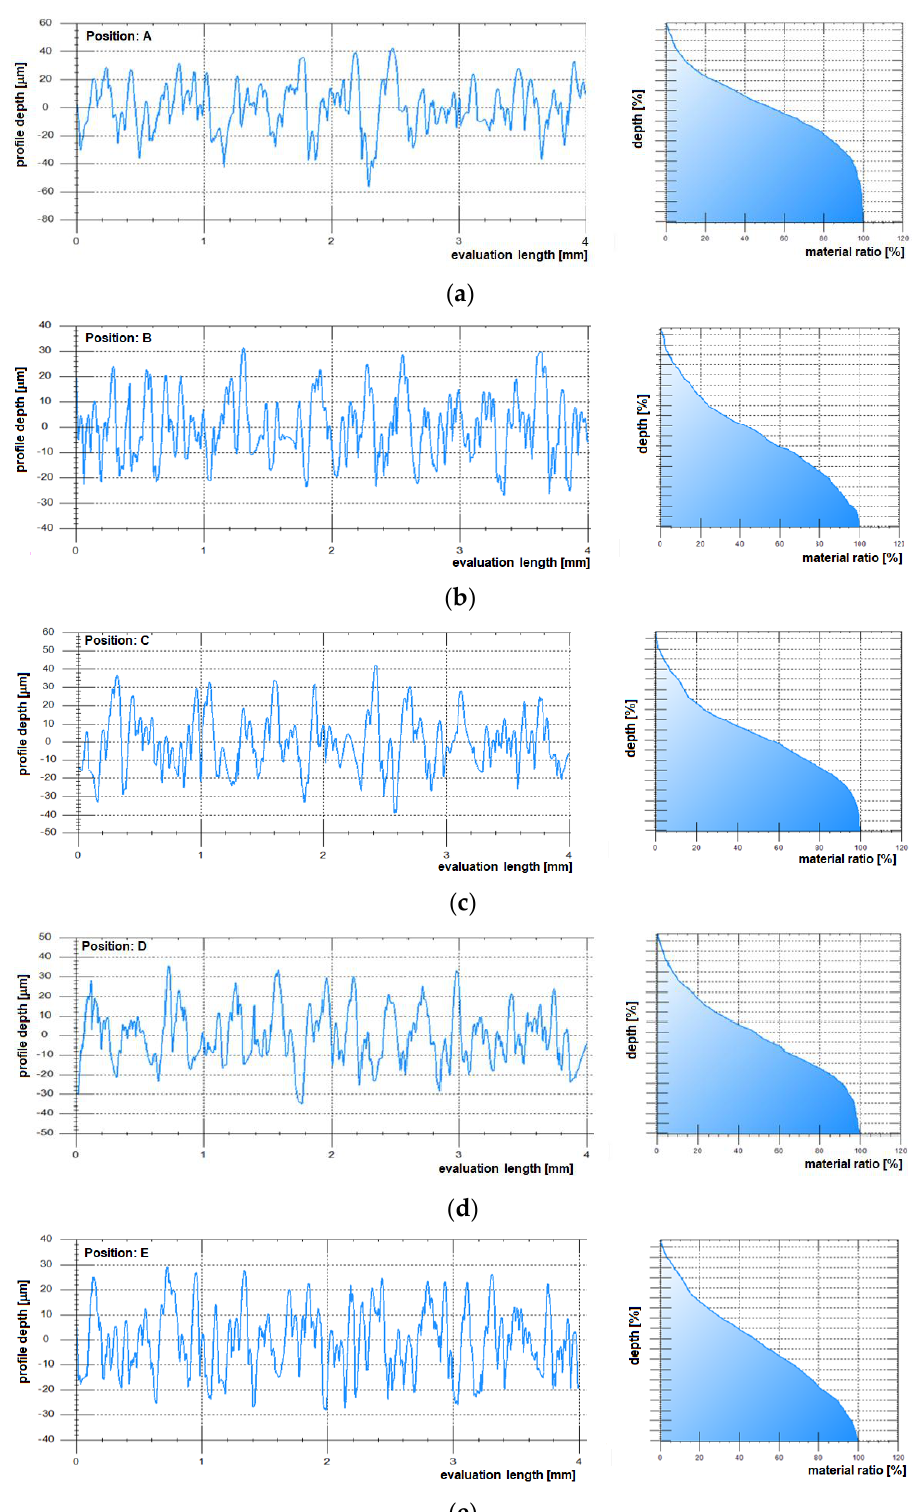
Figure 10. Profilographs ( left ) and areal material ratio Abbot – Firestone curves ( right ) of surfaces in particular positions: ( a ) position A, ( b ) position B, ( c ) position C, ( d ) position D, ( e ) position E.